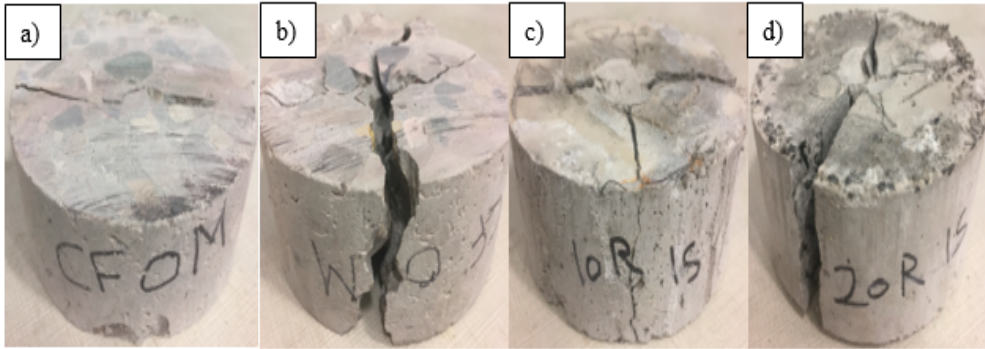
Figure 9. Failure pattern of the TSC specimens under impact loading: ( a ) control, ( b ) 0.5% steel wire, ( c ) 1% steel wire, and ( d ) 1.5% steel wire.